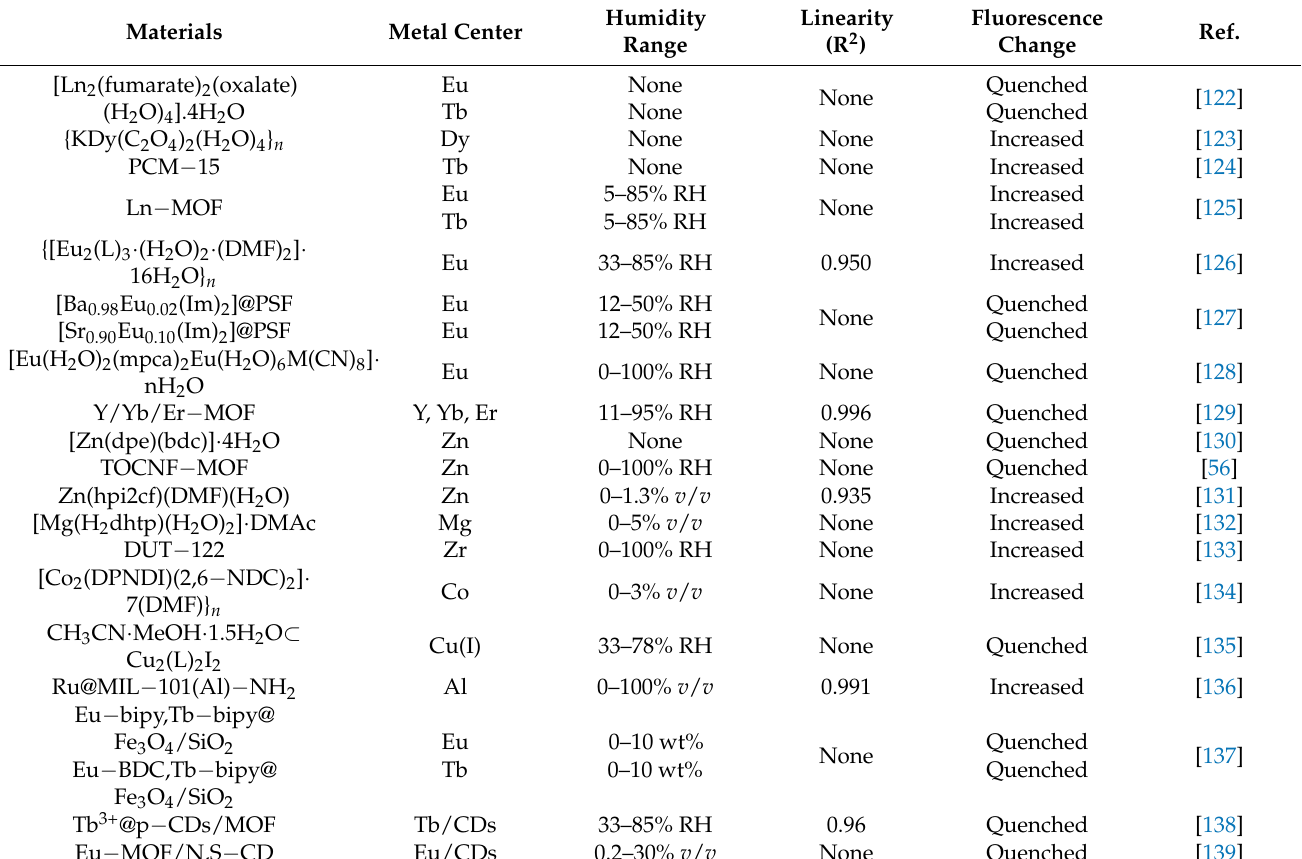
Table 4. Sensing properties of MOF − based fluorescent − type humidity